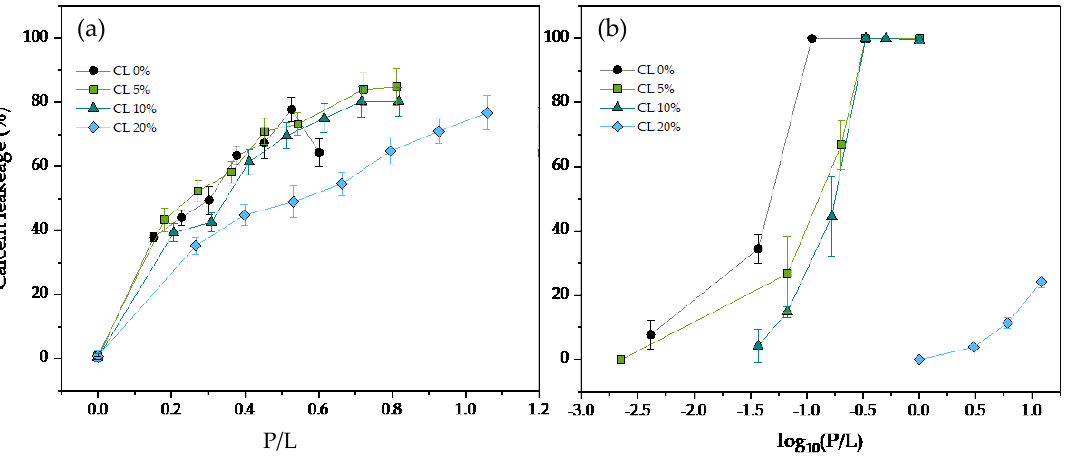
Figure 2. Percentage of calcein release as a function of the peptide to lipid molar ratio (P/L) for ( a ) LL − 37, and ( b ) ATRA − 1 in DMPG 100 nm unilamellar vesicles containing varying molar percent- ages of CL. All measurements were performed at 37 °C.